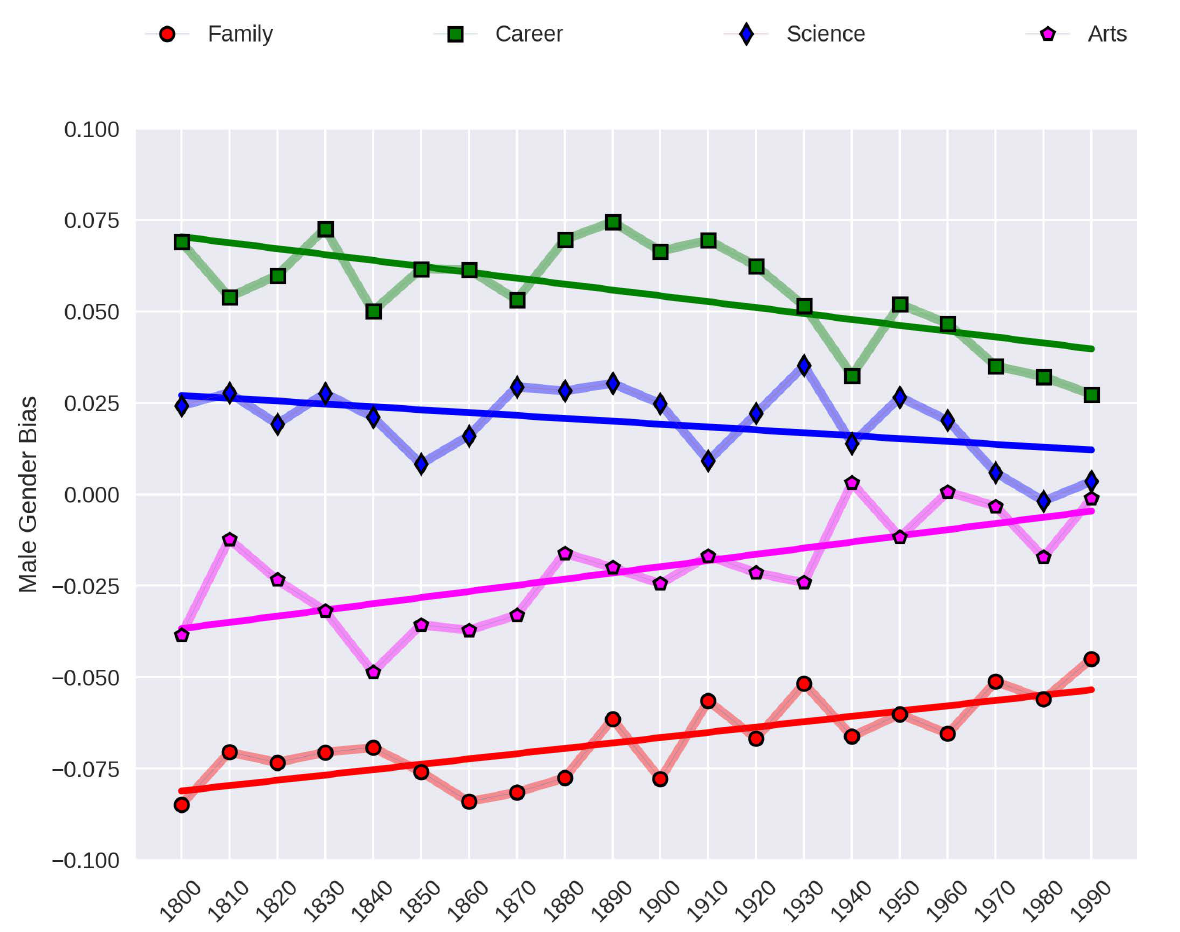
Figure 2: Male gender bias as measured by word embeddings in each decade of text for the four domains of Family, Career, Science, and Arts. Male gender bias is calculated by subtracting female cosine similarity from the male cosine similarity per each domain. The x axis is labeled with the first year of each decade (e.g., the label “1910” is used to mark the measurement based on the word embedding trained on text from 1910 up to but not including